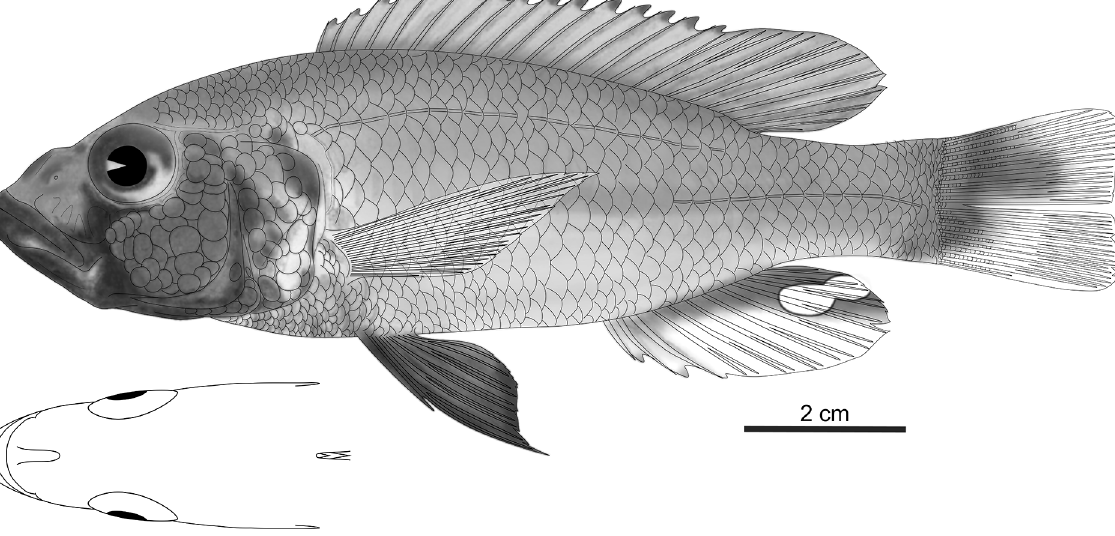
Fig. 20. Haplochromis aquila sp. nov., holotype, ♂, 113.6 mm SL (RMCA 2018.008.P.0355). Drawn by N.